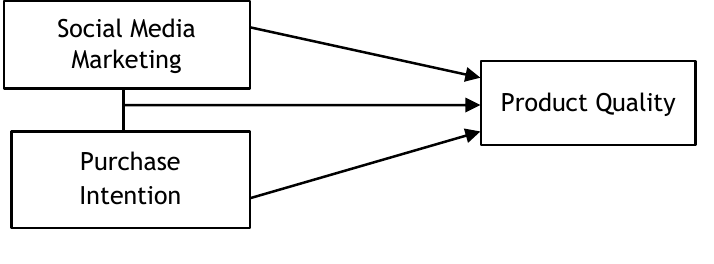
Figure 1. Conceptual